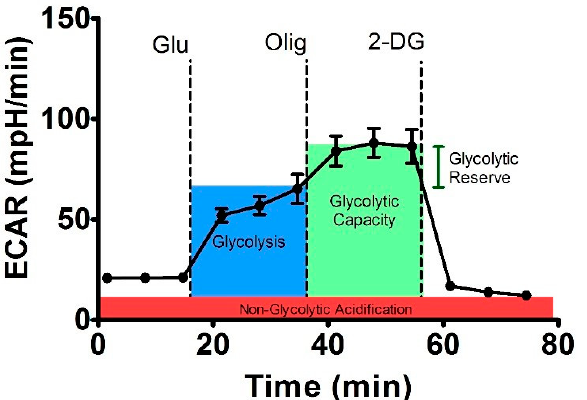
Figure 7. Scheme of the experiment for assessing the glycolytic capacity of the cell using the analyzer XF24 Seahorse Bioscience [49].